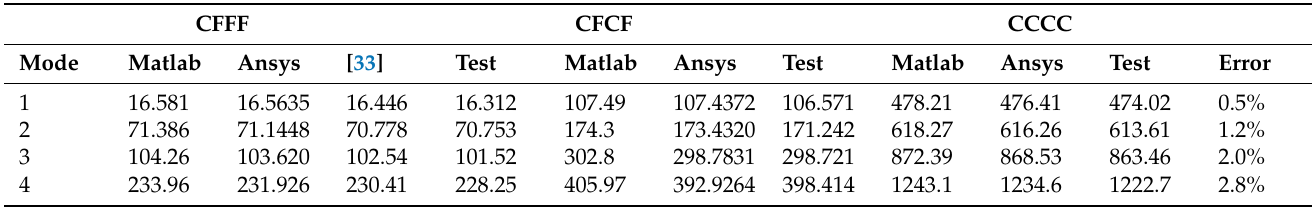
Table 1. Comparison of natural frequencies of substrates under different boundary conditions.